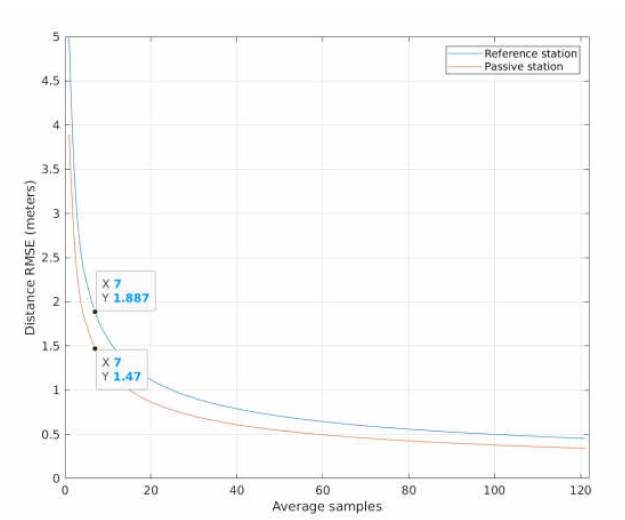
Figure 6. Average RMSE of the RTT and TDOA measurements for the IEEE 802.11mc and WiFi Passive TDOA stations, respectively. Distance-dependent error added to the time of flight (TOF) observables.